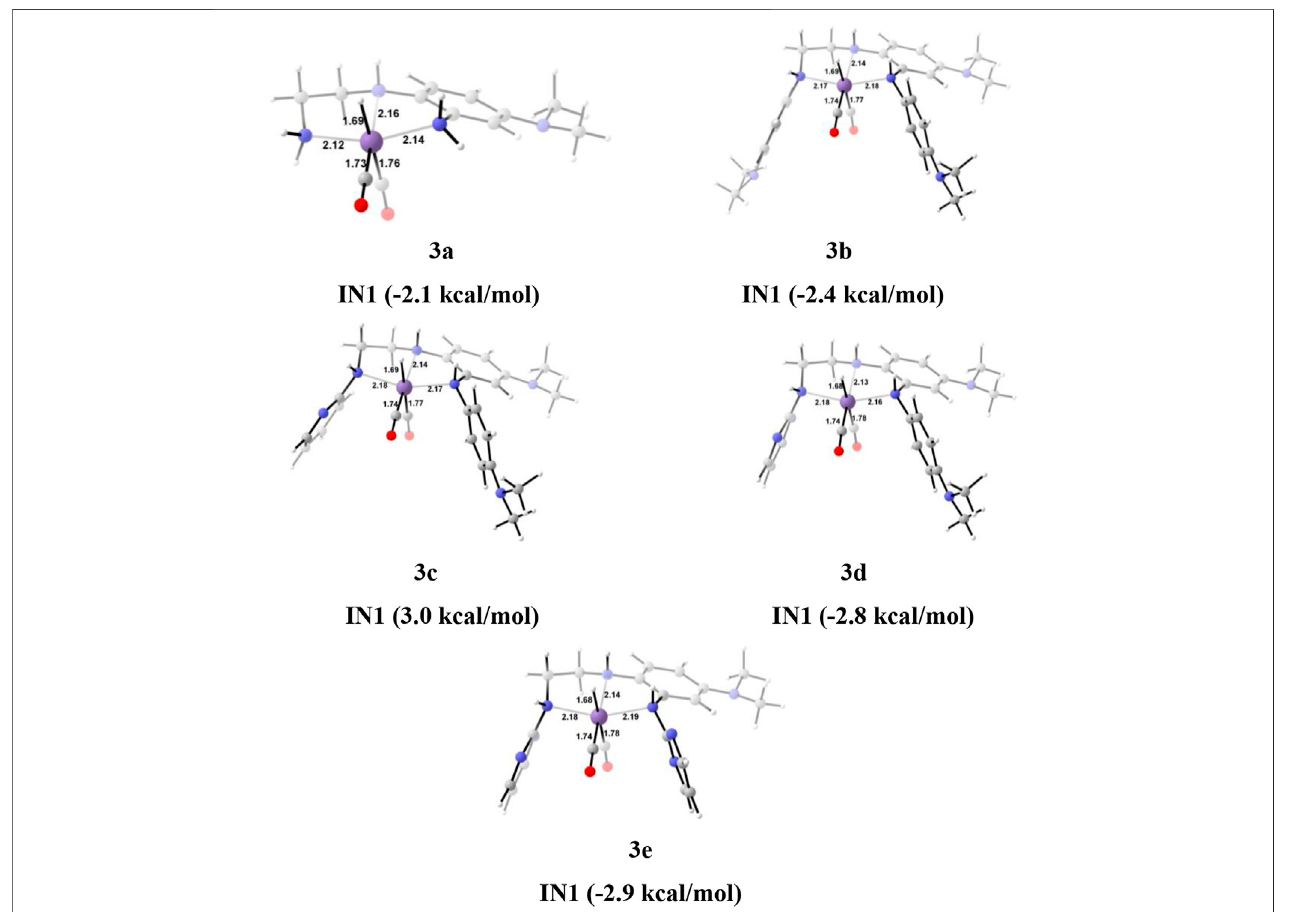
FIGURE10| Theoptimizedgeometriesofthe Group3IN1 catalysts.ThebondlengthsareinÅ,andrelativeGibbsfreeenergiesareinparentheses(Theoptimized geometries of all the transition states and intermediates are disclosed in Supplementary Data Sheet S1 ).